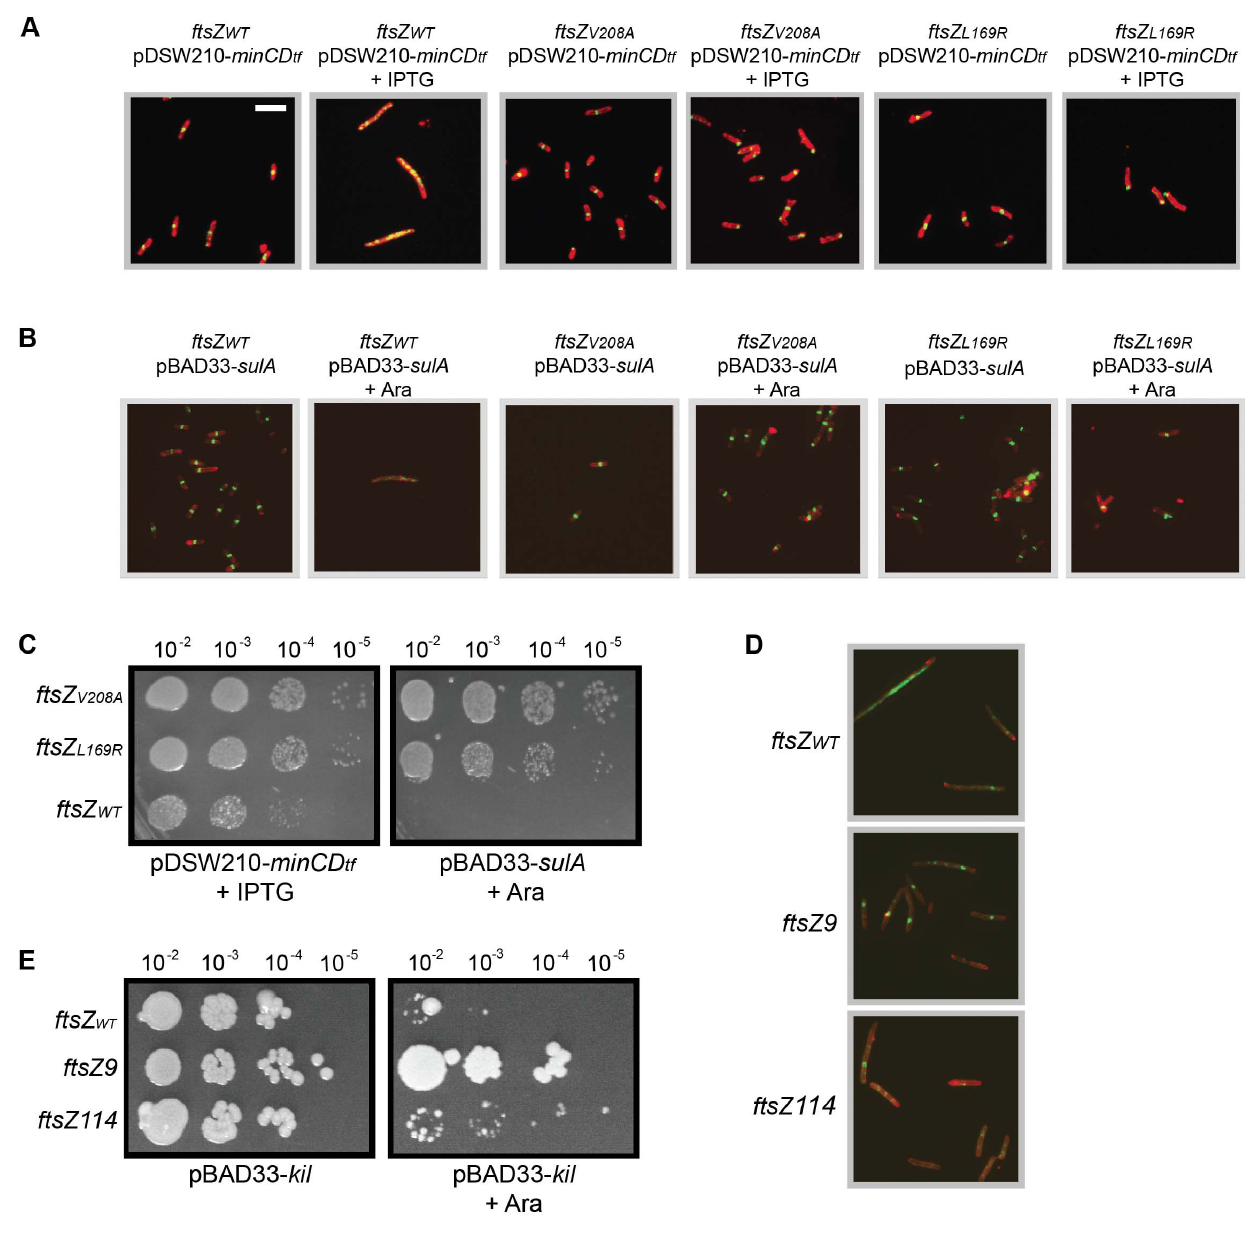
Figure 5. General resistance of isolated ftsZ alleles to assembly inhibition. (A) Cells with ftsZ V208A or ftsZ L169R form FtsZ rings and do not filament despite overexpression of minCD . Representative IFM micrographs are shown of cell wall (red) and a -FtsZ (green) signal from fixed cells of the CC4506 background strain with pDSW210- his - minCD ( minC-minD gene fusion) and the indicated ftsZ alleles grown at 30 u C (no kil induction) harvested after 40 minutes of minCD induction ( + IPTG) or non-inducing conditions. Cell wall and a -FtsZ signal are shown as in Figure 2. Scale bar=5 m m. (B) Cells with ftsZ V208A or ftsZ L169R form FtsZ rings and do not filament despite sulA overexpression. Shown are representative IFM micrographs of cell wall (red) or a -FtsZ (green) signal from fixed cells of the CC4506 background strain with pBAD33- sulA and the indicated ftsZ alleles grown at 30 u C (no kil induction) harvested after 40 minutes of sulA induction ( + Ara) or non-inducing conditions. Signal and scale are as in (A). (C) The ftsZ mutations confer resistance to minCD - or sulA -induced lethality. Spot dilutions are shown of the CC4506 background strain with pDSW210- his - minCD or pBAD33- sulA and the indicated ftsZ alleles plated at 30 u C (no kil expression) on LB agar with 1 mM IPTG ( + IPTG) or 0.2% arabinose ( + Ara). (D) Cells with the characterized ftsZ9 and ftsZ114 alleles partially suppress inhibition of FtsZ ring formation by Kil. Shown are representative IFM micrographs of cell wall (red) or a -FtsZ (green) signal from fixed cells containing the indicated ftsZ allele and pBAD33- kil grown after 40 minutes of kil induction ( + Ara). Signal and scale as in (A). (E) Cells with the ftsZ9 allele completely suppress, and those with the ftsZ114 allele partially suppress the loss of viability upon kil expression. Shown are spot dilutions of cells containing the indicated ftsZ allele and pBAD33- kil plated on LB agar with (right) or without (left) 0.2% arabinose at the indicated